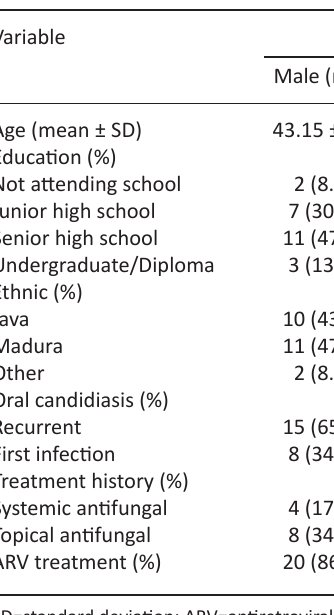
Table 1. Demographic and Clinic Characteristics of patient Gender